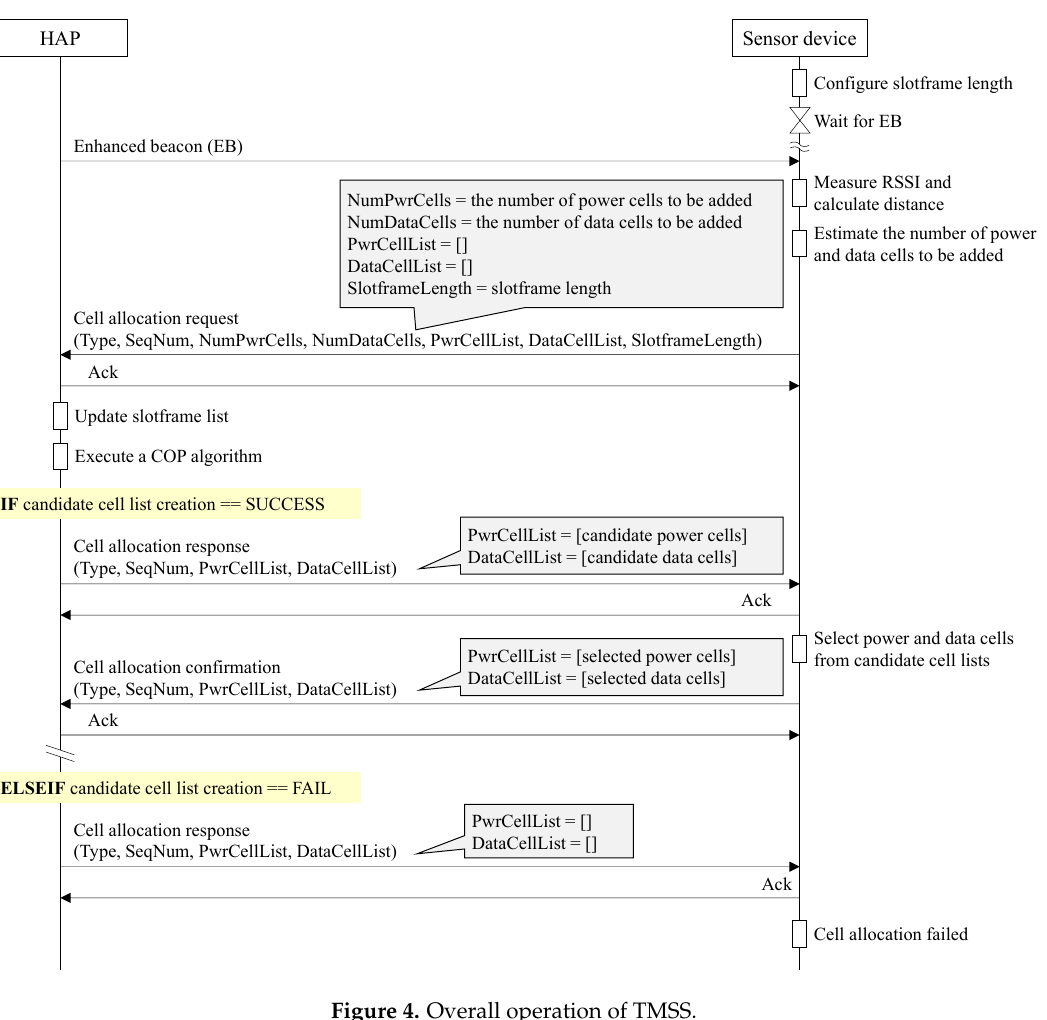
Figure 5. Timing diagram for a timeslot. To obtain the number of power cells to be added in the configured slotframe ( pwrCells N